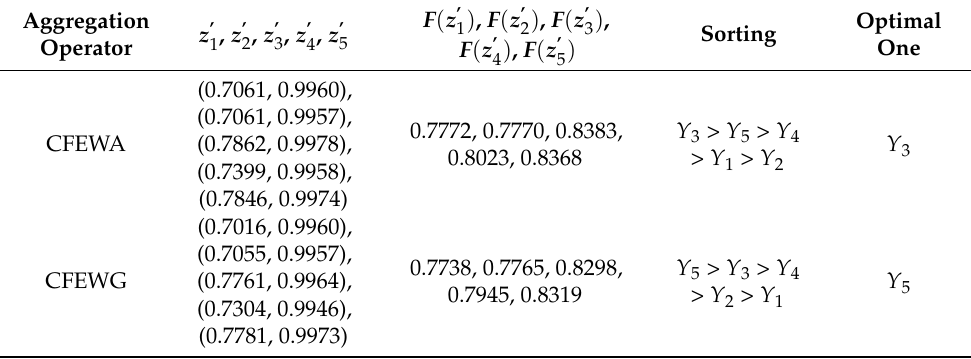
Table 3. Decision results of the existing decision-making method in the case of CFEs [19]. Aggregation